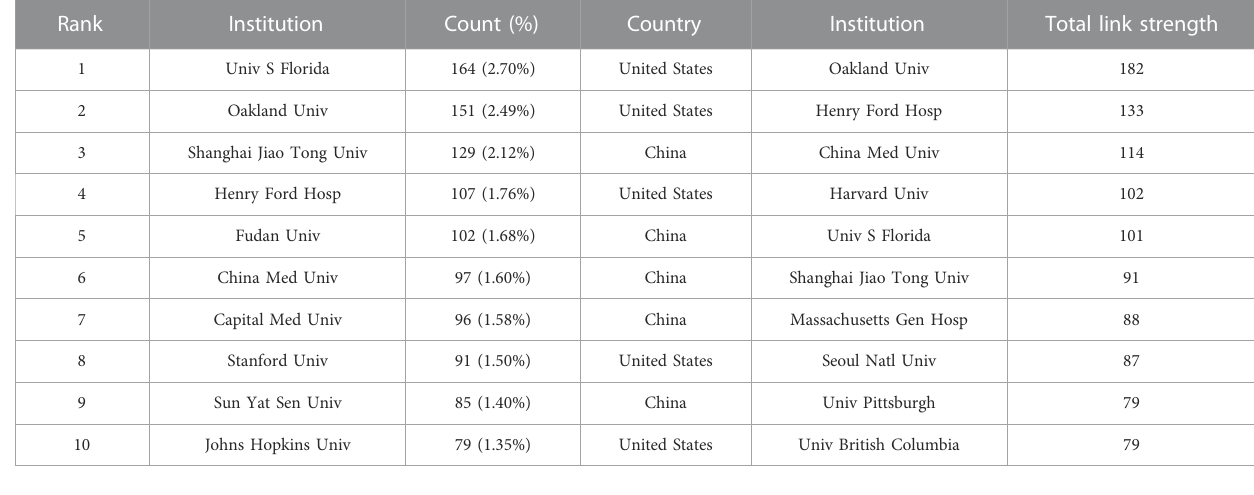
TABLE 2 Top 10 institutions related to stem cells in stroke.